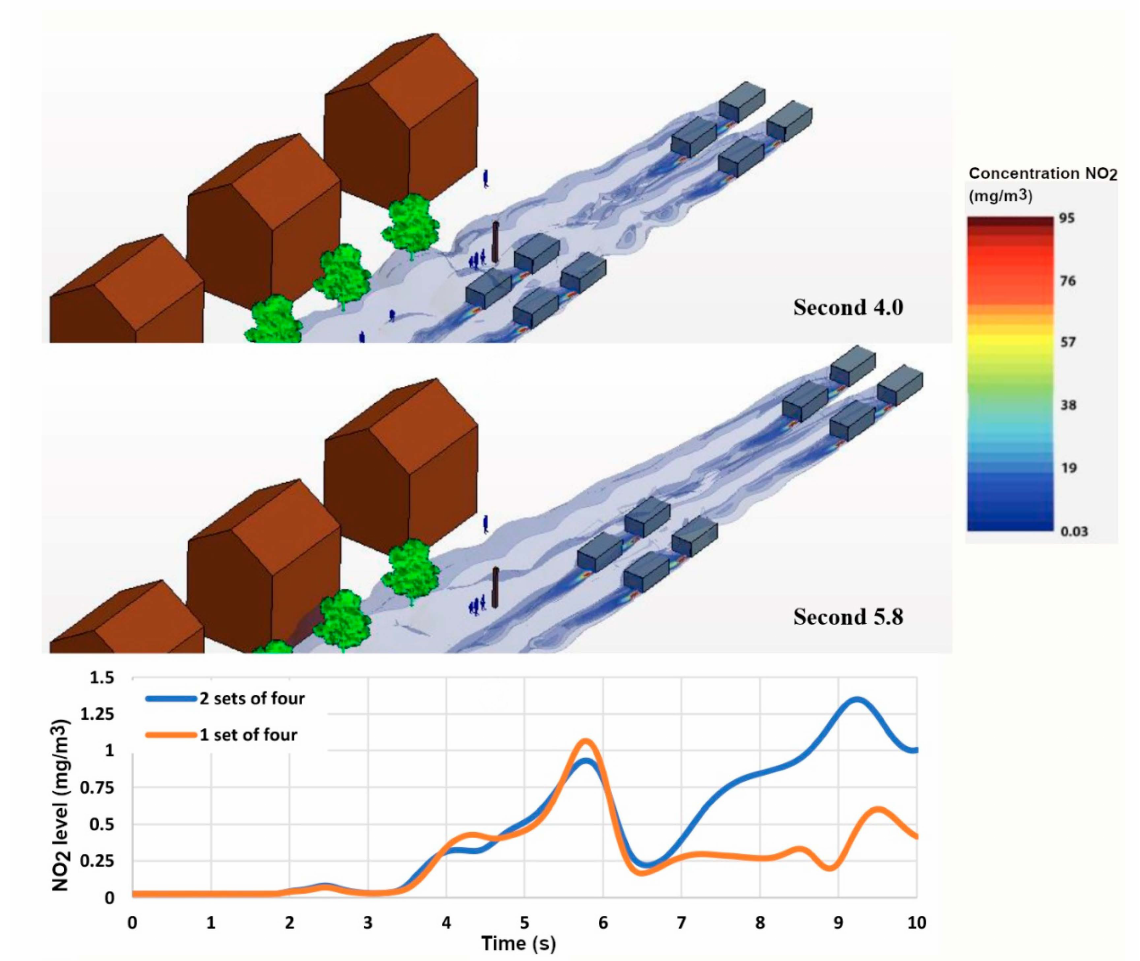
Figure 6. Comparison of NO 2 concentrations from one and two sets of Euro 5 vehicles, for the teenager